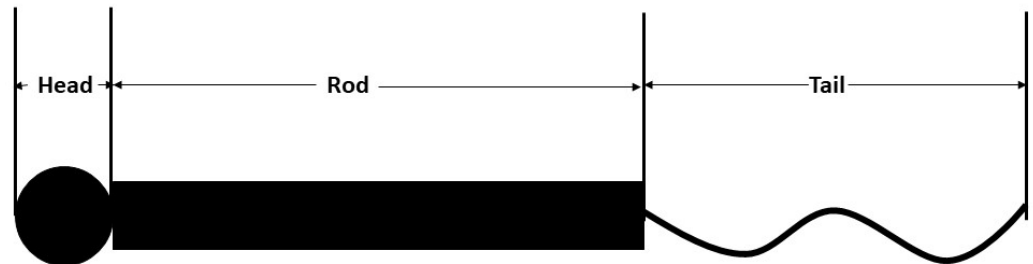
Figure 1. NF structure depicting the head, rod, and tail domains. The head and rod domains are almost the same for all isoforms, while the length of the tail domain is variable, increasing in length from light isoform (NF-L) to heavy isoform (NF-M and NF-H). For details, the reader may refer to the work of Jayanthi [30]. The image is solely for obtaining an idea about different domains of NF and is not drawn to scale.